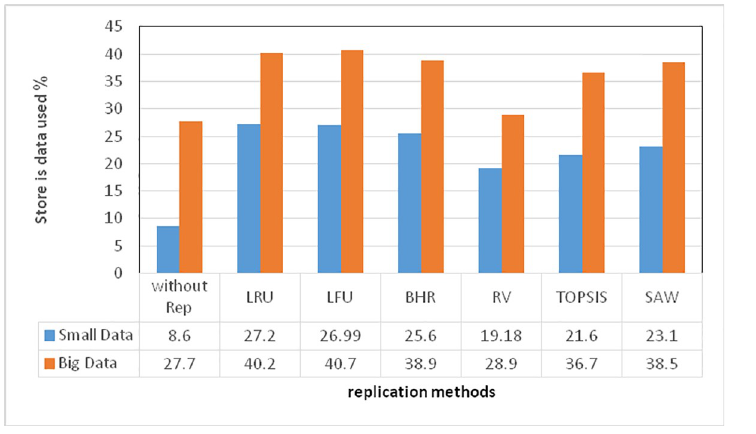
Fig 2. Space taken up by data replication algorithms.